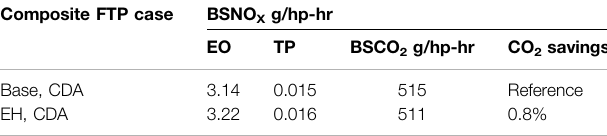
TABLE 4 | Cummins X15 engine